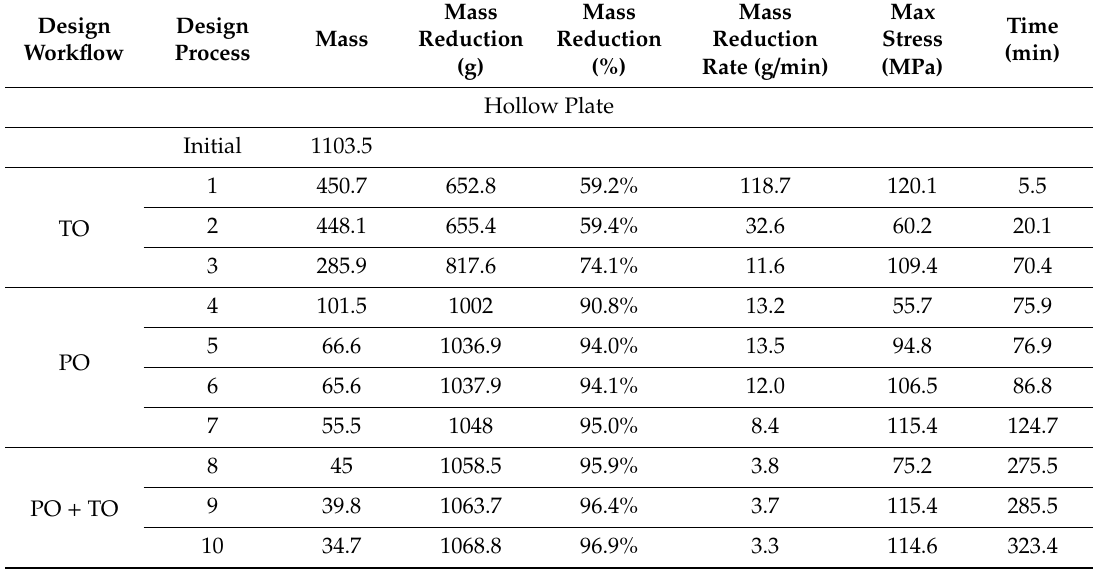
Table 8. An overview of the simulations’ results in the three case